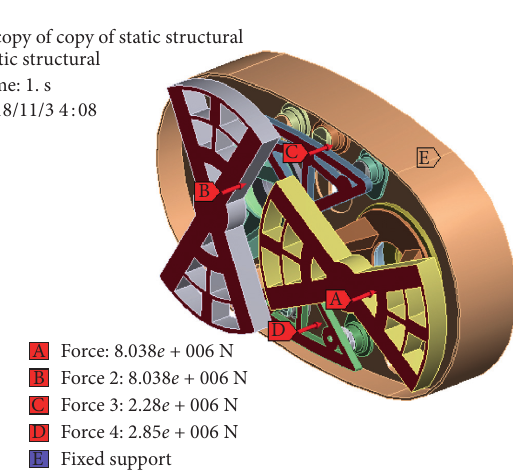
Figure 12: Boundary condition setting.